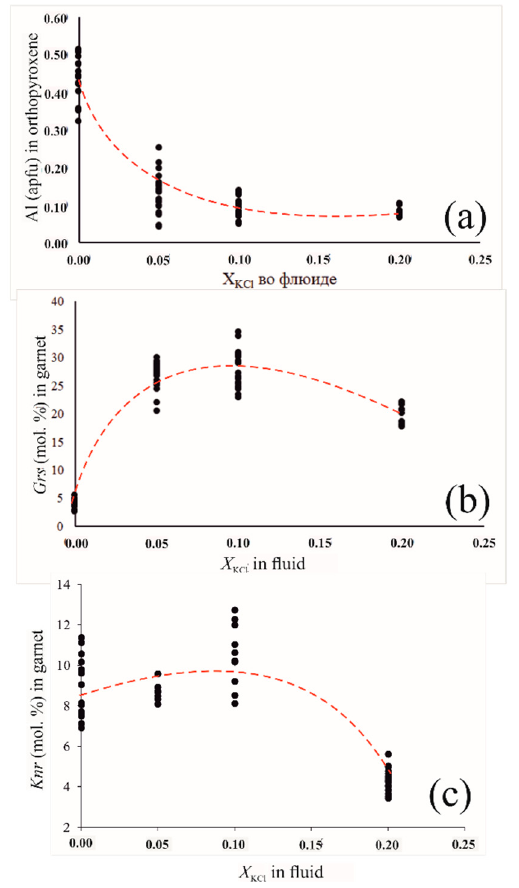
Figure 4. Dependence of phase compositions in the systems enstatite–pyrope–grossular–H 2 O–KCl and enstatite–pyrope–knorringite–H 2 O–KCl on the salt concentration in a fluid at 5 GPa. ( a ) Al in orthopyroxene (atoms per formula unit, apfu); ( b ) grossular in garnet (mol. %); ( c ) knorringite in garnet (mol. %).